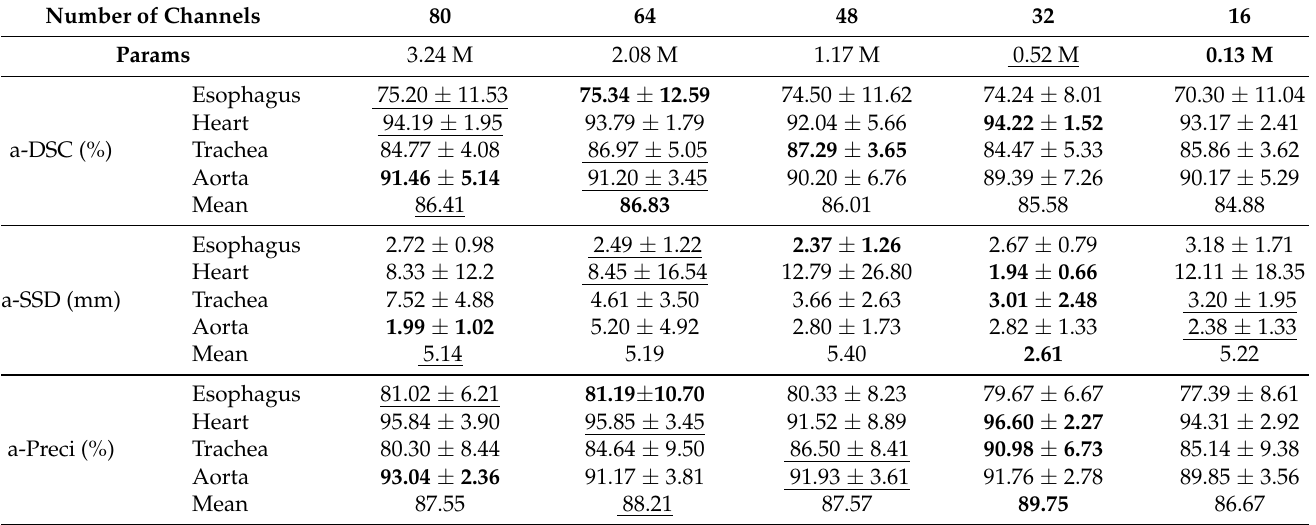
Table 5. Quantitative assessment with the a-DSC, a-SSD, and a-Preci values of different channel numbers p using the proposed 2D FAS-UNet framework on the 2D SegTHOR validation datasets with four organs: esophagus, heart, trachea, and aorta. “Mean” denotes an average score segmenting all organs. The best and second places are highlighted in bold font and underlined,